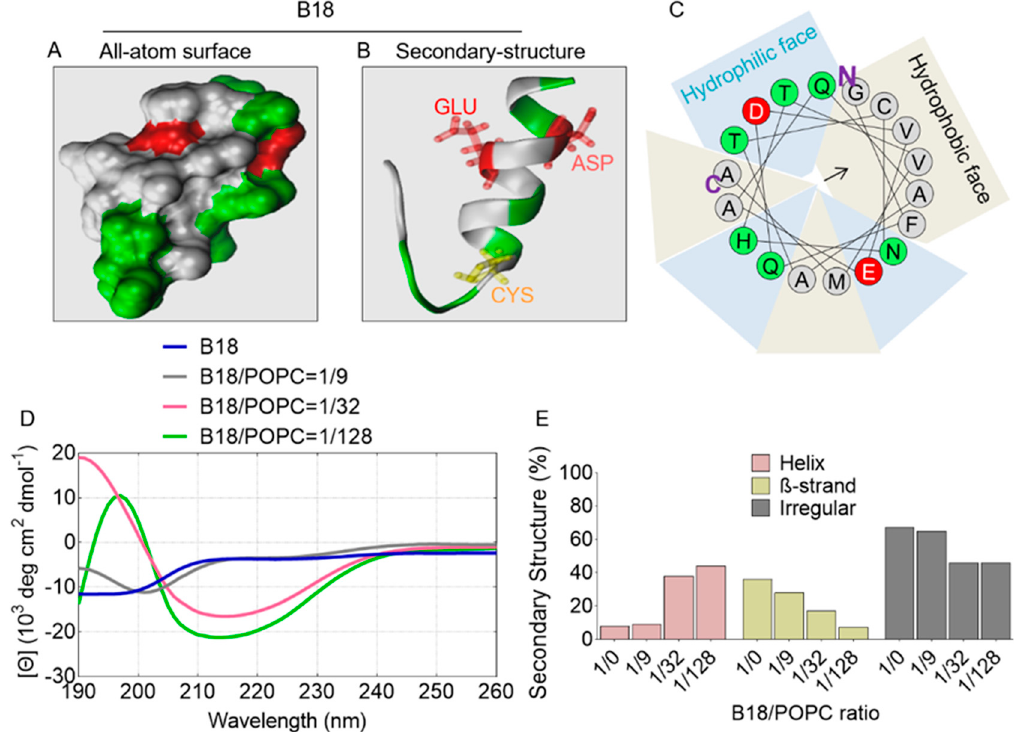
Figure 6. Predicted structure of B18 peptide. ( A ) All-atom surface. ( B ) Secondary structure with three residues’ side chains (GLU, ASP, CYS). ( C ) Helical wheel projection of B18, N : N-terminus, and C : C-terminus. Color code: red: acidic residue, green: polar residue, white: non-polar residue and yellow: CYS residue. ( D ) Circular dichroism (CD) of B18 in water or in different concentrations of POPC lipid solution. ( E ) Predicted secondary structure based on the CD analysis.